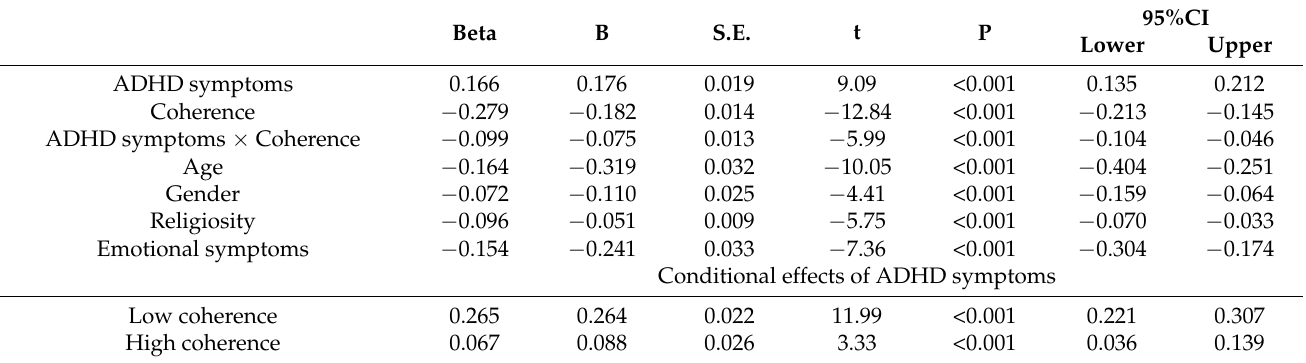
Table 7. ADHD symptoms as a predictor of public order antisocial behavior moderated by coher- ence.